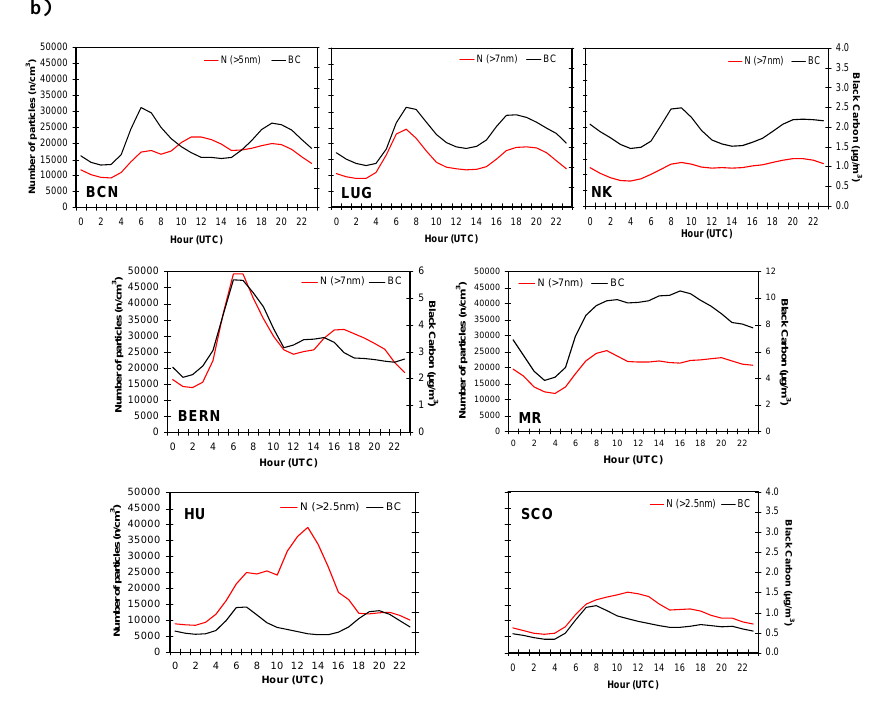
Fig. 2b. Daily cycle of: Black Carbon (BC) and Number concentration (N) levels for each monitoring site.